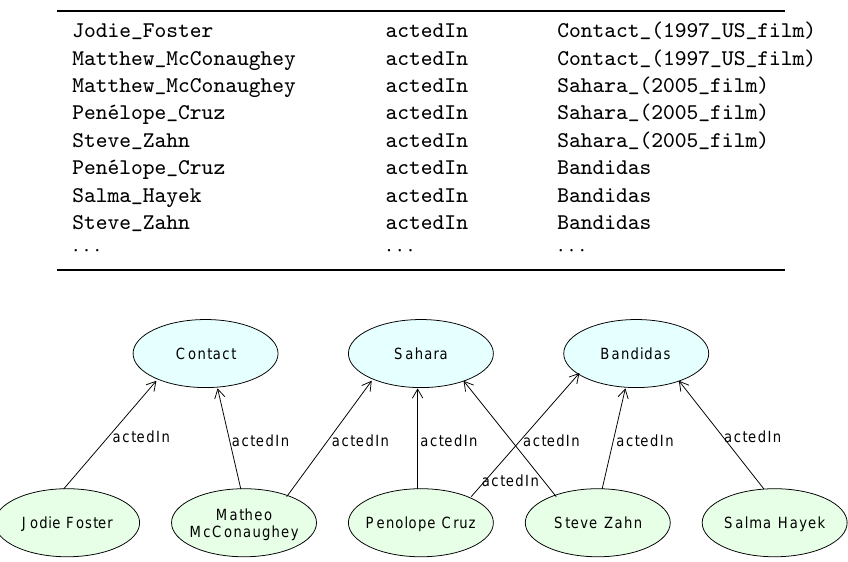
Table 1. A subset of RDF triples from YAGO with yago:actedIn predicate.